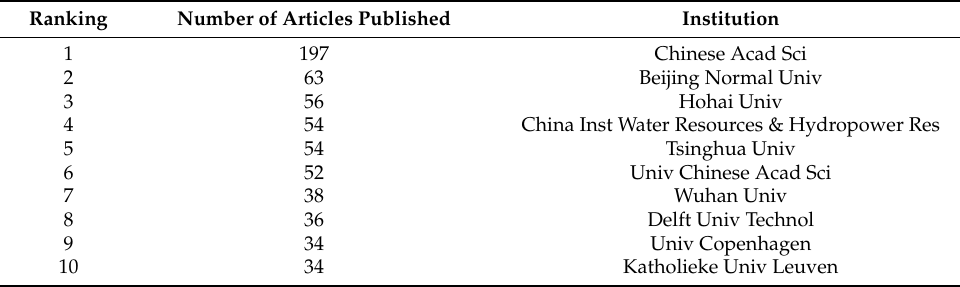
Table 1. Top 10 research institutions in terms of publication volume.